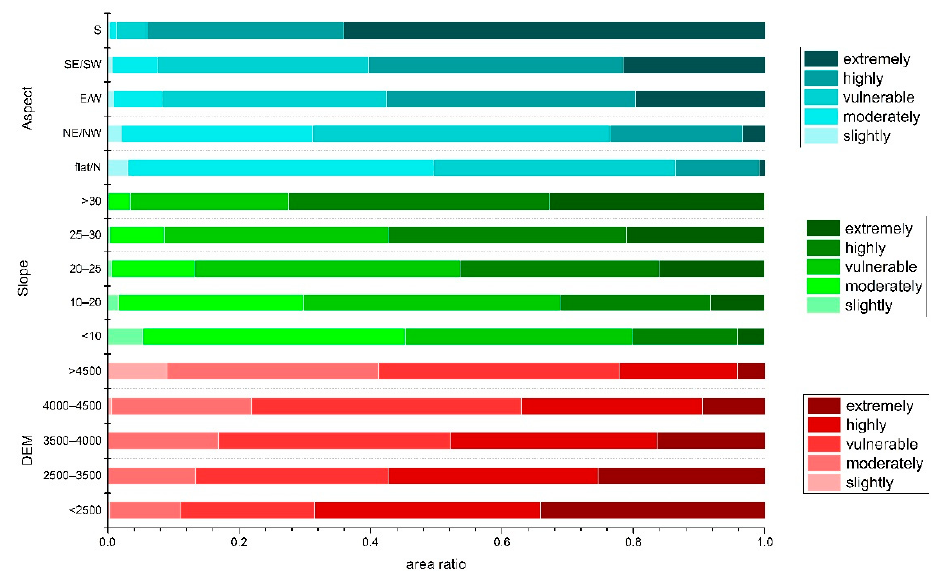
Figure 9. Proportion of different vulnerability levels at different altitudes, slopes, and slopes.